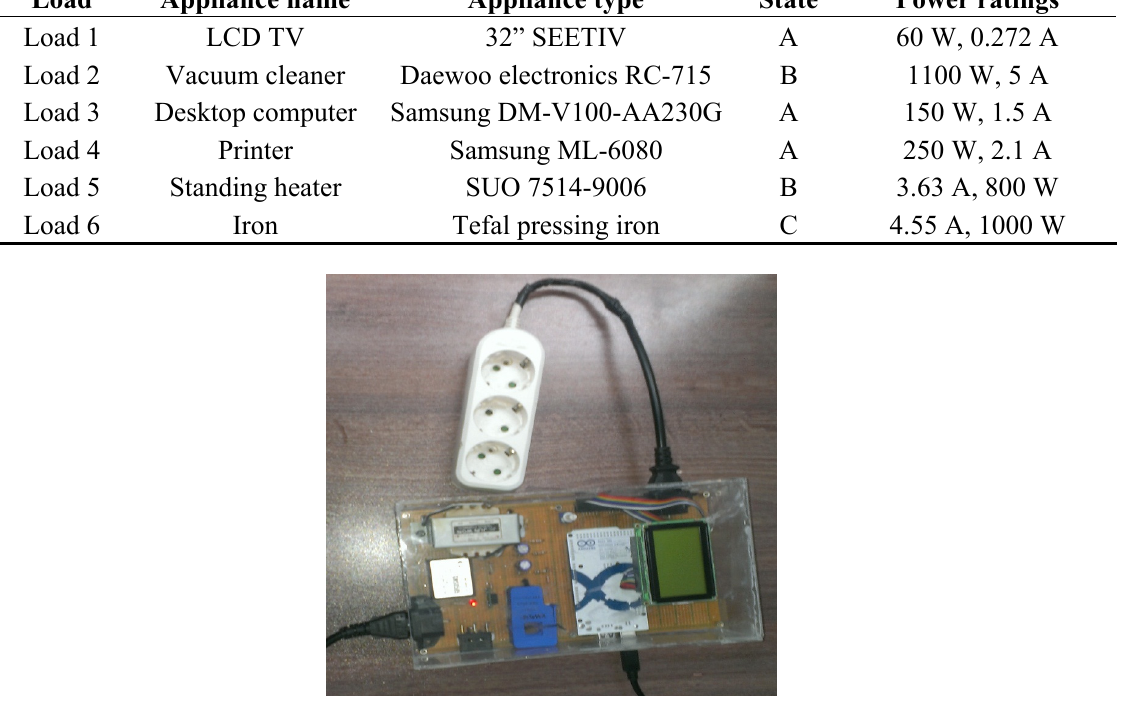
Figure 6. Recognition energy meter.